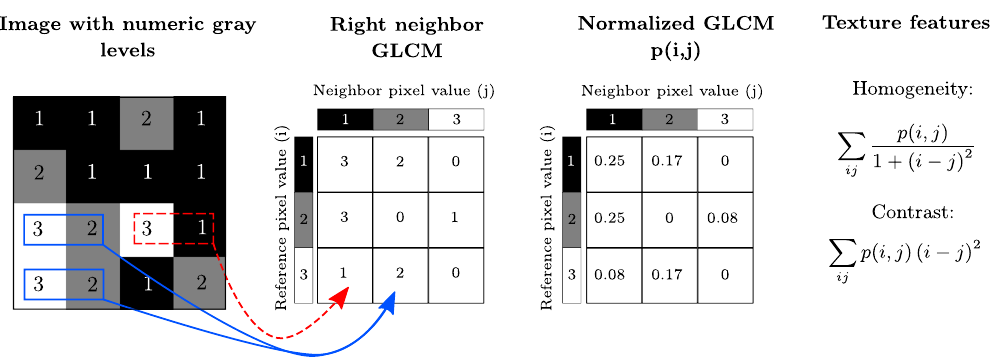
Figure 4. A description of how Haralick’s texture features are calculated. In an example 4 × 4 image ROI, three gray levels are represented by numerical values from 1 to 3. The GLCM is constructed by considering the relation of each voxel with its neighborhood. In this example we only look at the neighbor to the right. The GLCM acts like a counter for every combination of gray level pairs in the image. For each voxel, its value and the neighboring voxel value are counted in a specific GLCM element. The value of the reference voxel determines the column of the GLCM and the neighbor value determines the row. In this ROI, there are two instances when a reference voxel of 3 “co-occurs” with a neighbor voxel of 2, indicated in solid blue, and there is one instance of a reference voxel of 3 with a neighbor voxel of 1, indicated in dashed red. The normalized GLCM represents the frequency or probability of each combination to occur in the image. The Haralick texture features are functions of the normalized GLCM, where different aspects of the gray level distribution in the ROI are represented. For example, diagonal elements in the GLCM represent voxels pairs with equal gray levels. The texture feature “contrast” gives elements with similar gray level values a low weight but elements with dissimilar gray levels a high weight. It is common to add GLCMs from opposite neighbors (e.g. left-right or up-down) prior to normalization. This generates symmetric GLCMs, since each voxel has been the neighbor and the reference in both directions. The GLCMs and texture features then reflect the “horizontal” or “vertical” properties of the image. If all neighbors are considered when constructing the GLCM, the texture features are direction